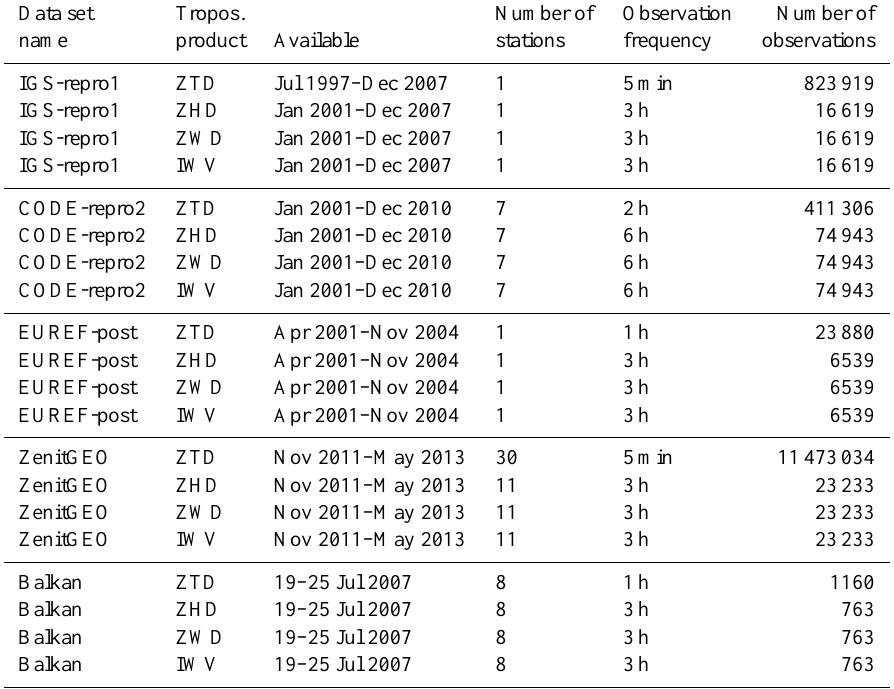
Table 2. GNSS data sets as of 1 October 2013. Data set Tropos. Number of Observation Number of name product Available stations frequency